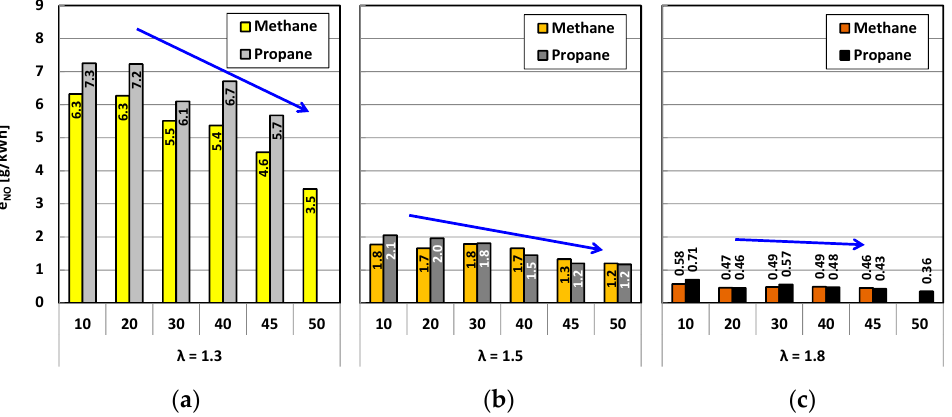
Figure 17. Hydrocarbon emissions at di ff erent values of energy supplied to the prechamber: ( a ) λ =